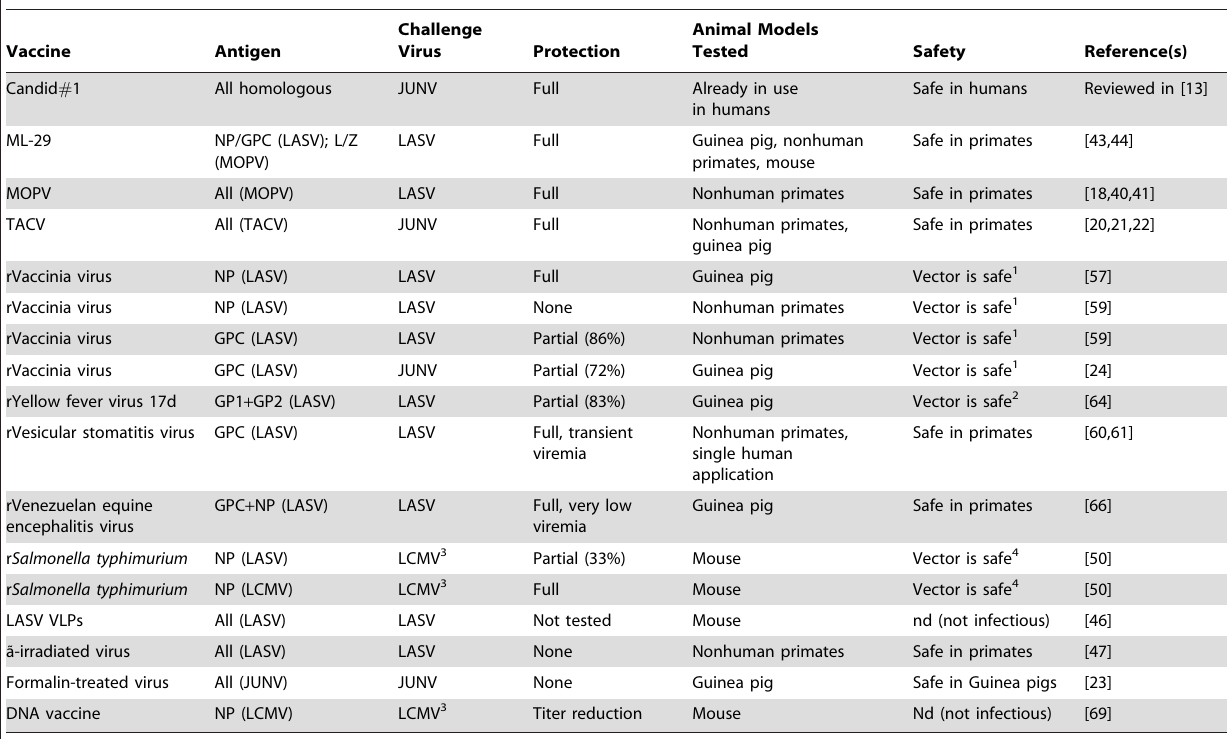
Table 3. Summary of selected animal JUNV and LASV vaccine